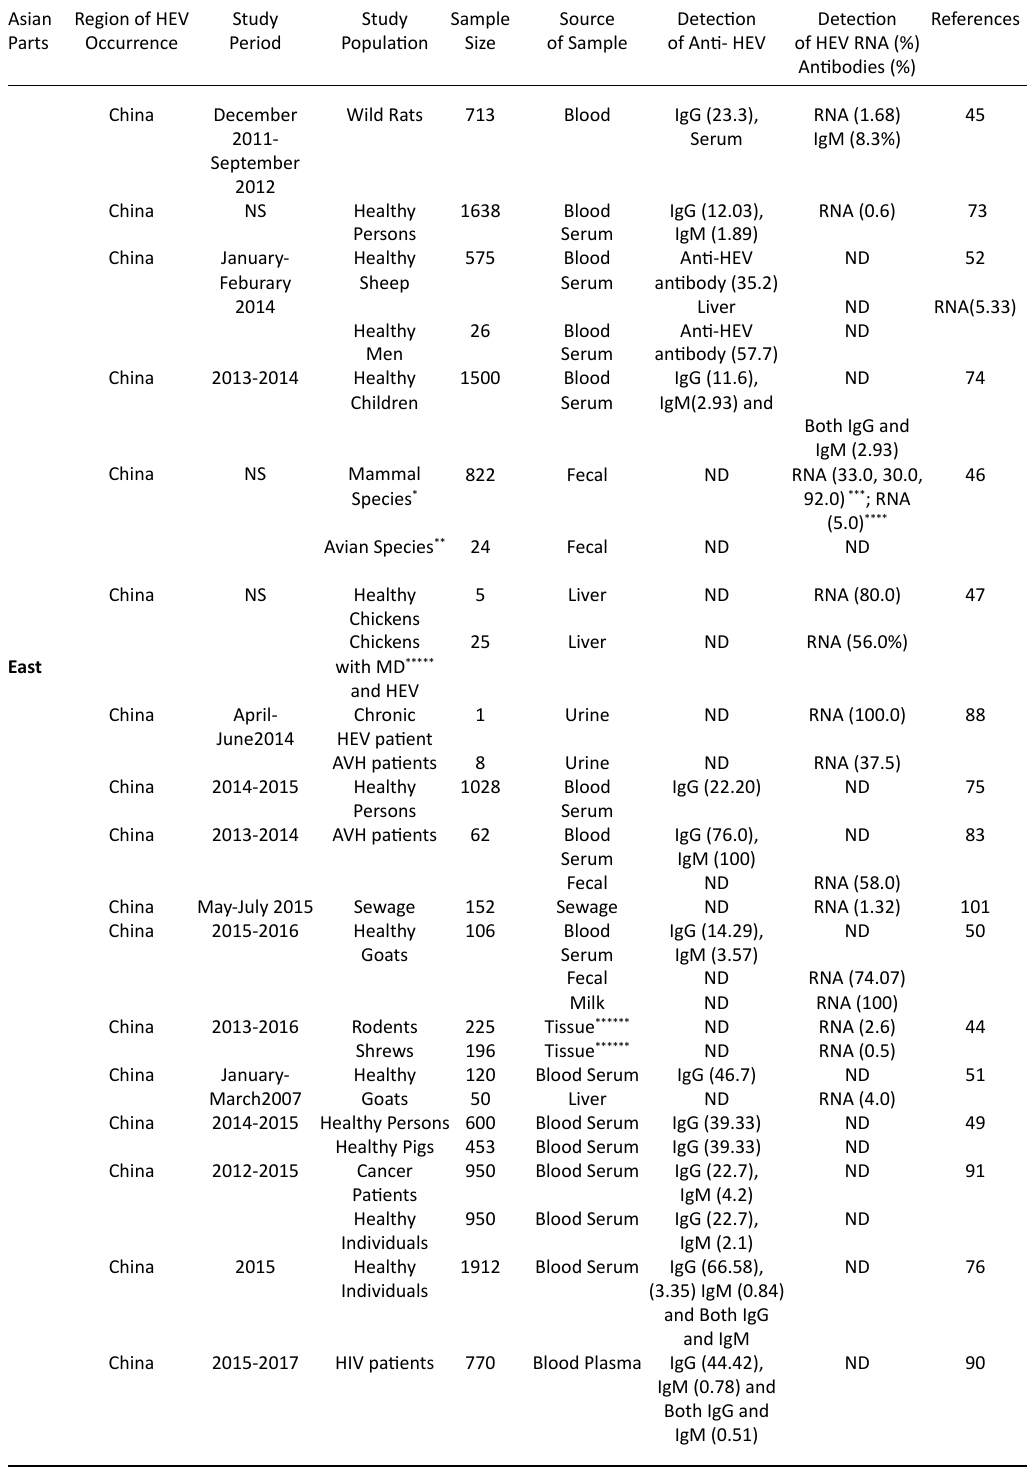
Table 3. Prevalence of Hepatitis E Virus (HEV) cases in Asia from 2013- 2018 Asian Region of